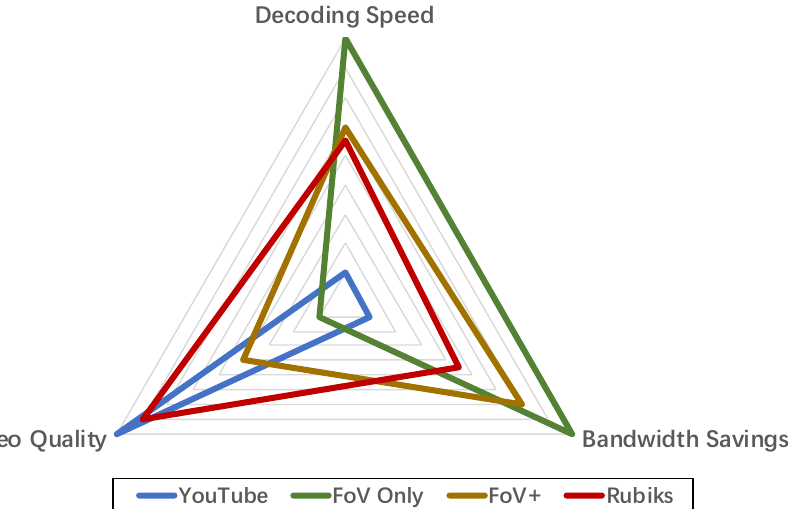
Figure 3. Design space of streaming